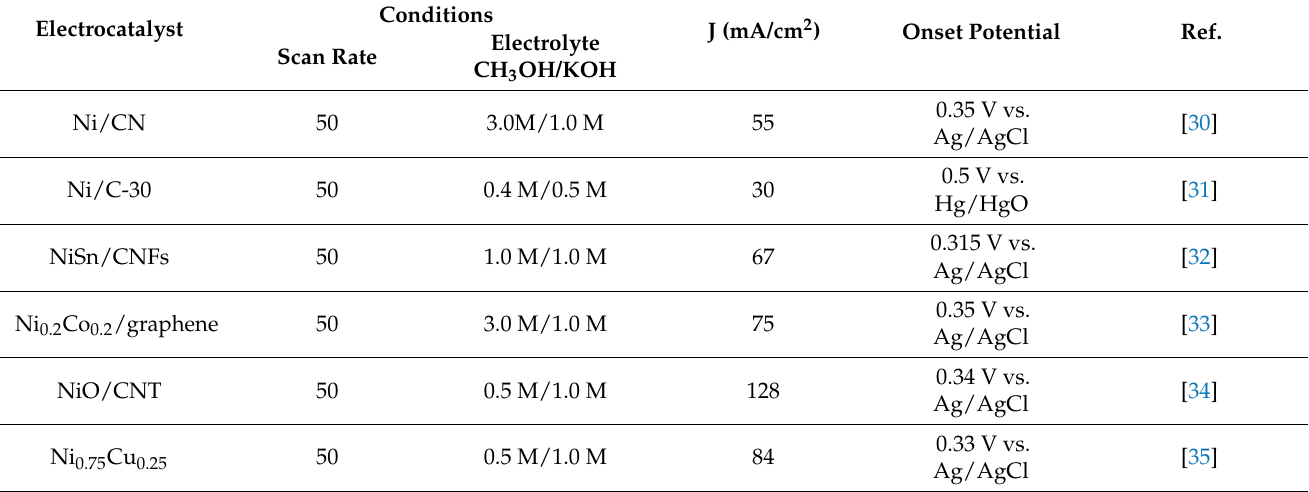
Table 1. Comparison of the catalytic activity of Ni-based catalysts toward methanol oxidation in alkaline